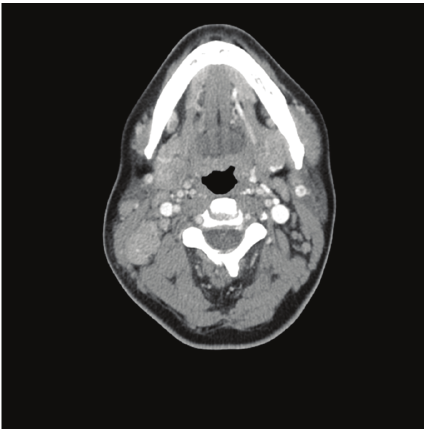
Figure 1: CT scan showing anterior and posterior cervical lym- phadenopathy.